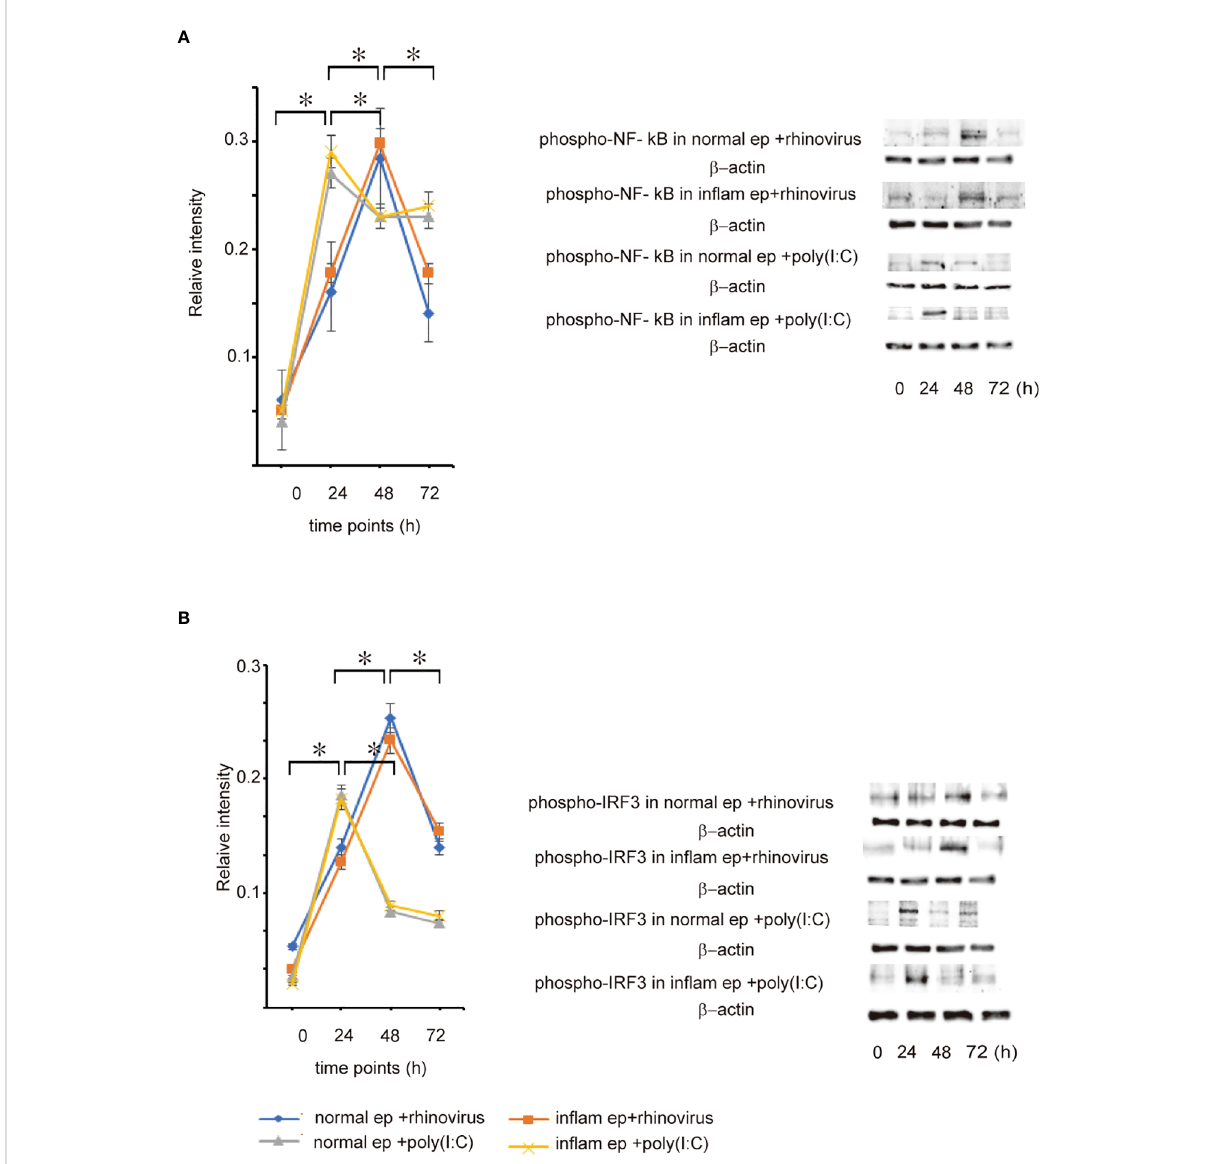
FIGURE 5 The expression level of phospho-NF- k B (A) and phosphor-IRF3 (B) protein in cultured normal and in fl ammatory sinonasal epithelial cells obtained from healthy control and patients with CRSwNP, respectively. Their levels were evaluated 24, 48, and 72 h after RV 16 inoculation and poly (I: C) treatment, which were evaluated by western blot. Right panels located in the fi gure show representative protein bands evaluated with western blot. Data are mean ± SEM from 7 different epithelial donors. Normal ep + rhinovirus indicates that cultured normal epithelial cells were infected with RV 16. In fl am ep + rhinovirus indicates that cultured in fl ammatory epithelial cells were infected with RV 16. Normal ep + poly (I: C) means poly(I: C)-treated cultured normal epithelial cells. In fl am + poly (I:C) means poly (I:C)-treated cultured in fl ammatory epithelial cells. * indicates a signi fi cant difference between each